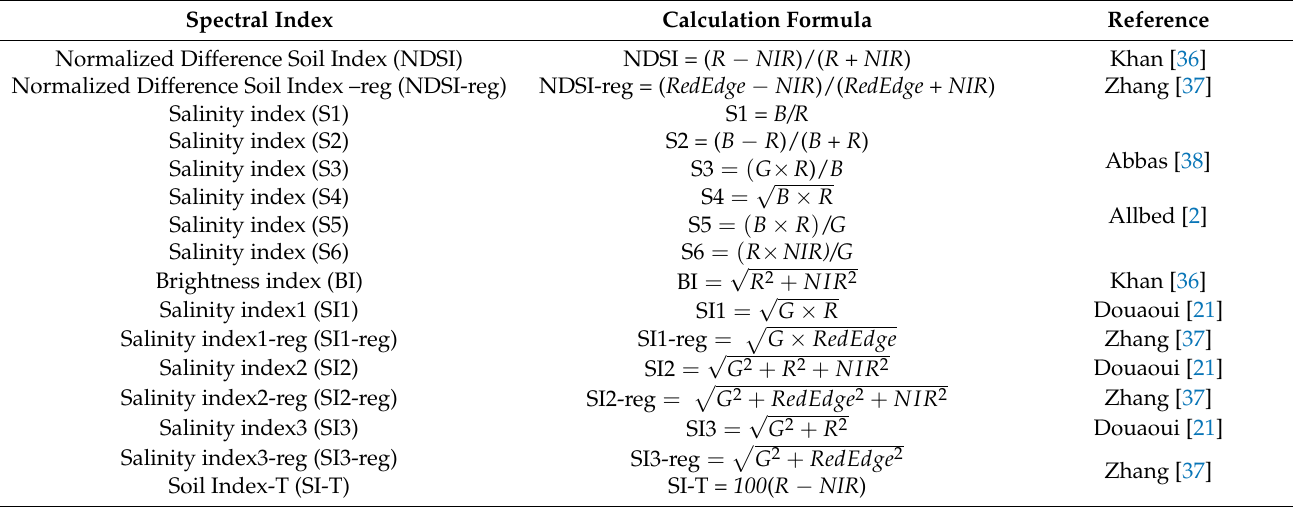
Table 2. The calculation formulae of the salinity